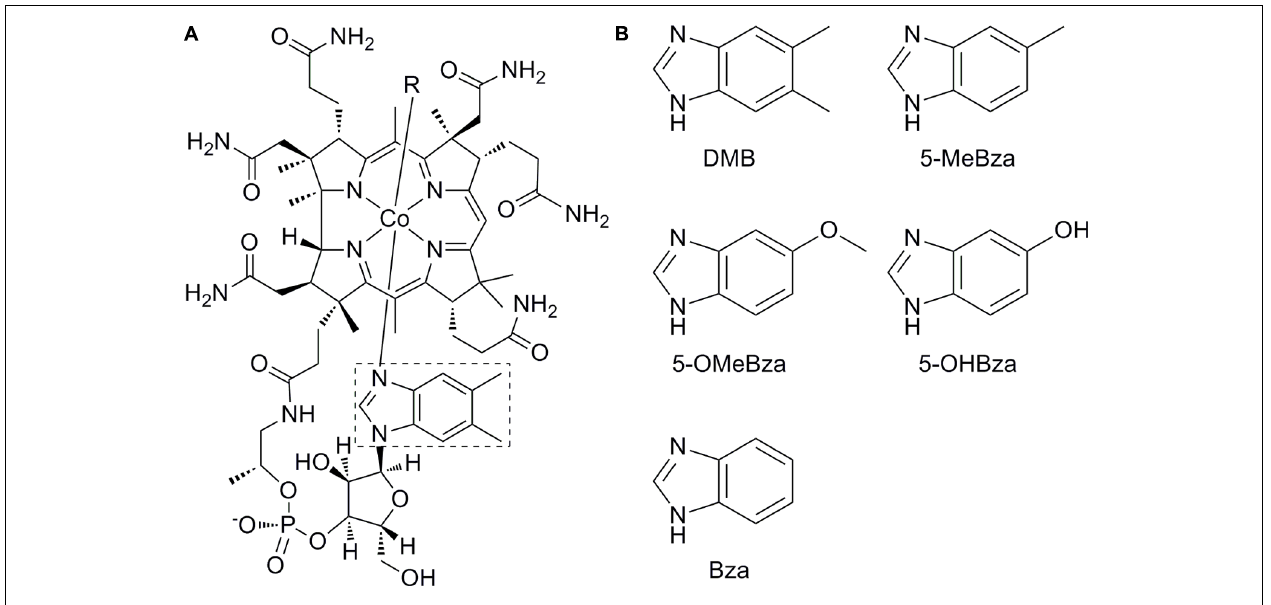
FIGURE 1 | Structure of cobalamin and benzimidazole lower ligands. (A) Structure of cobalamin. The lower ligand, 5,6 -dimethylbenzimidazole (DMB) is boxed. (B) Structures of lower